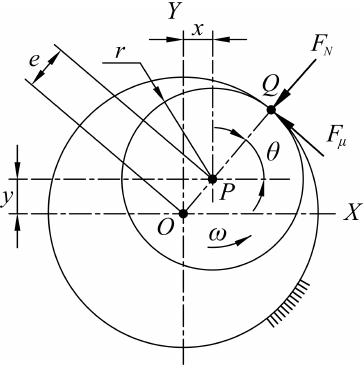
Figure 4. Schematic representation of a dry friction